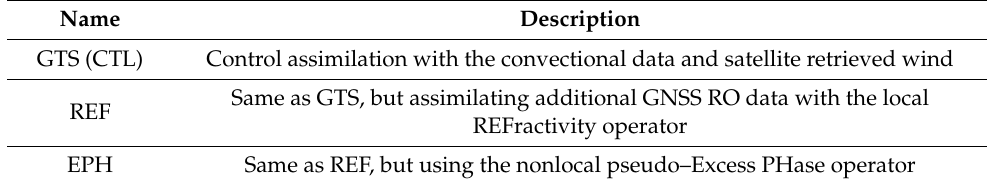
Figure 2. ( a ) The flowchart of the hybrid WRFDA data assimilation system. The ETKF employs 32 members with the outermost domain to provide the background error covariance. Both ETKF and 3DEnVar were conducted for the domain with the 15-km resolution, and the final analysis was adopted for the two domains of 15-km and 3-km resolutions. ( b ) The experimental design. Each simulation was carried out by 1-day cycling data assimilation with a 6-h cycling interval and then forecast for 5 days. Table 1. Experimental design for Typhoon Haishen